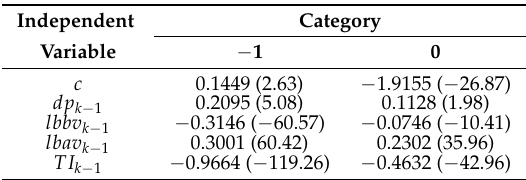
Table 7. Coefficient estimates of multinomial logistic regression model parameters fitted to Trade indicator ( TI ) of AGL. The base category is 1. Z statistics are given in